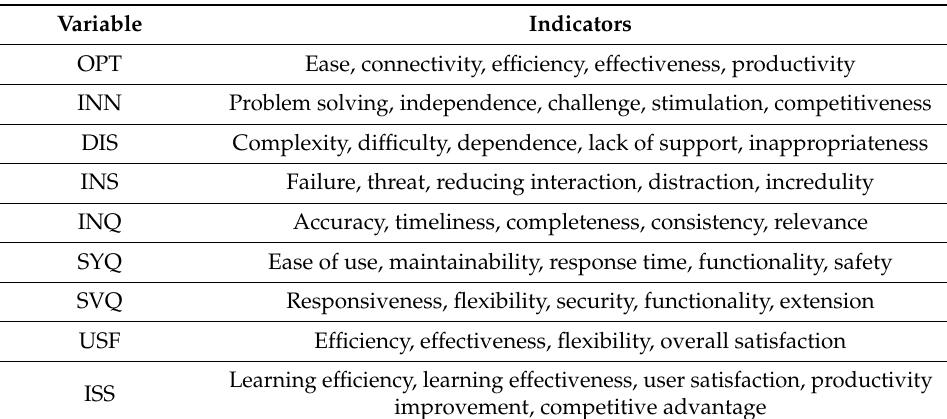
Table 1. List of indicators [39,40].